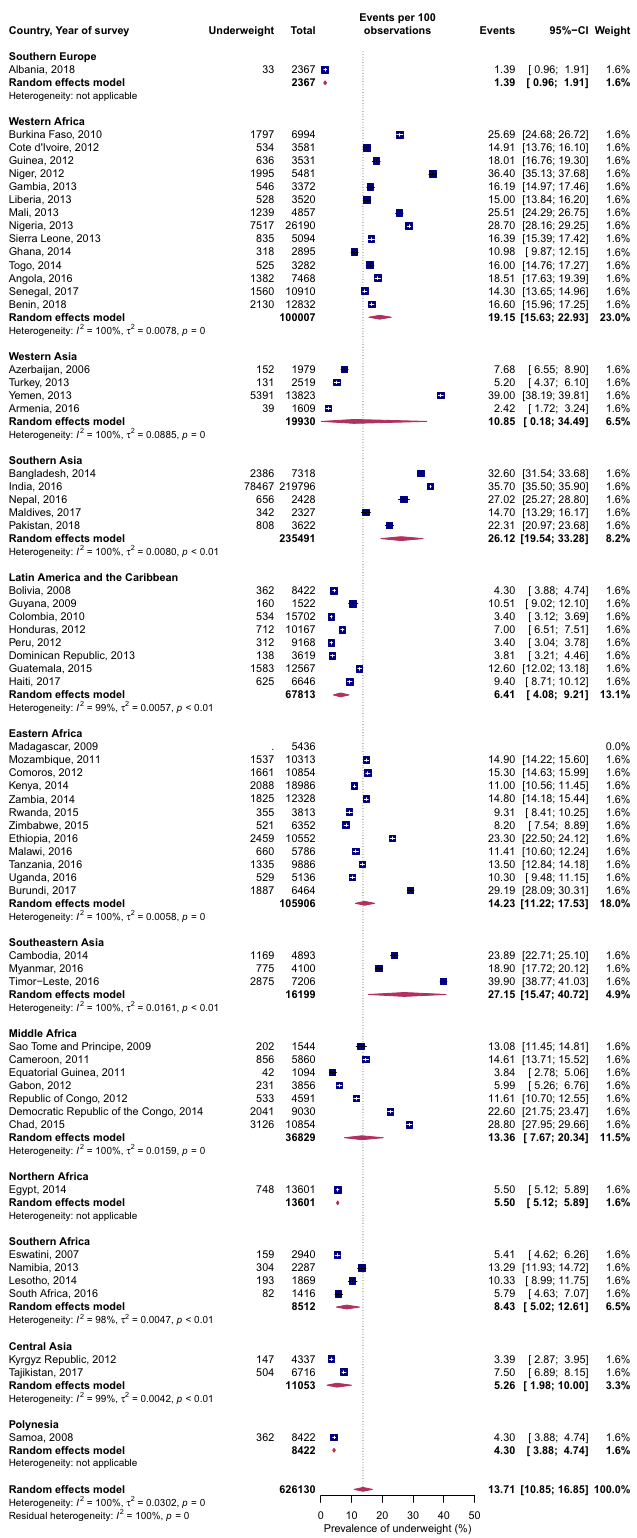
Figure 4. Forest plot of underweight prevalence by UN subregions of LMICs: event values represent the number of cases of underweight expressed as a percentage. Blue squares and their corresponding lines are the point estimates and 95% confidence intervals (95% CI). Maroon diamonds represent the pooled estimate of the prevalence for each subgroup (width denotes 95% CI). Weights are from the random-effects meta-analysis model described by DerSimonian and Laird 20 ( p for interaction comparing the different subgroups <